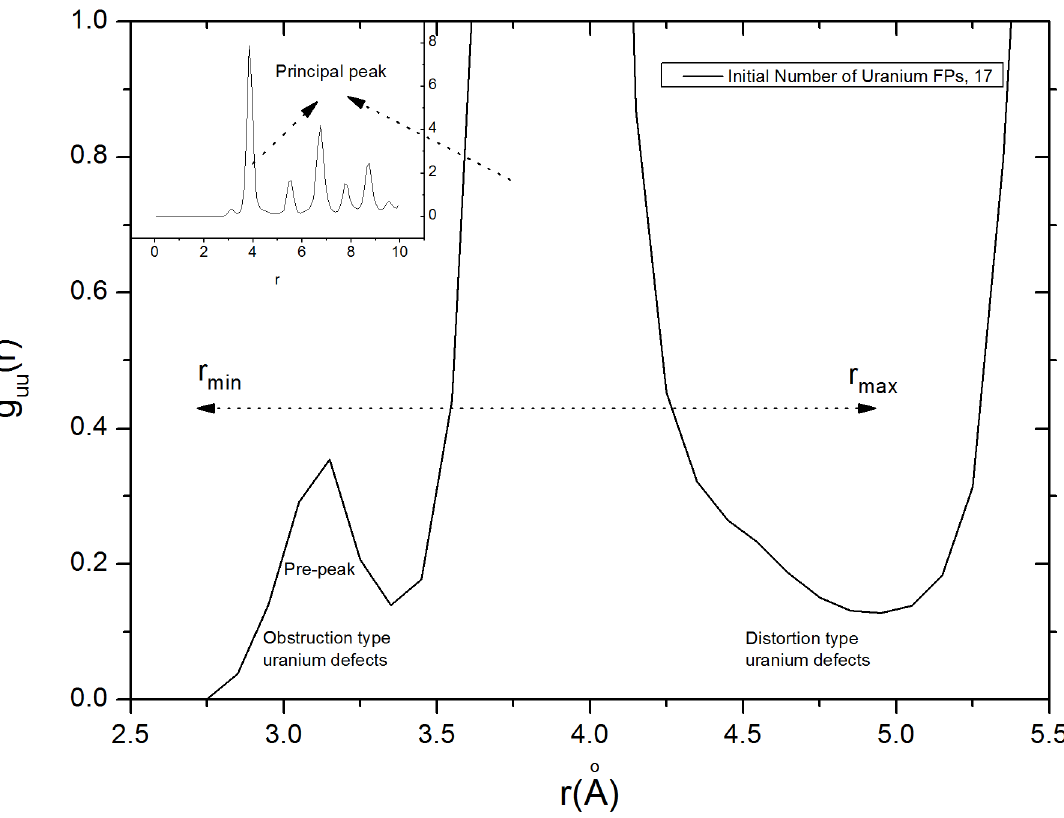
Fig 3. Radial distribution function, g uu ( r ), of a 5×5×5 MD UO 2 supercell with 17 uranium IFPs. Obstruction and distortion type defects are indicated on the graph. Obstruction type defects have sharper boundaries (pre-peaks) than distortion type defects.